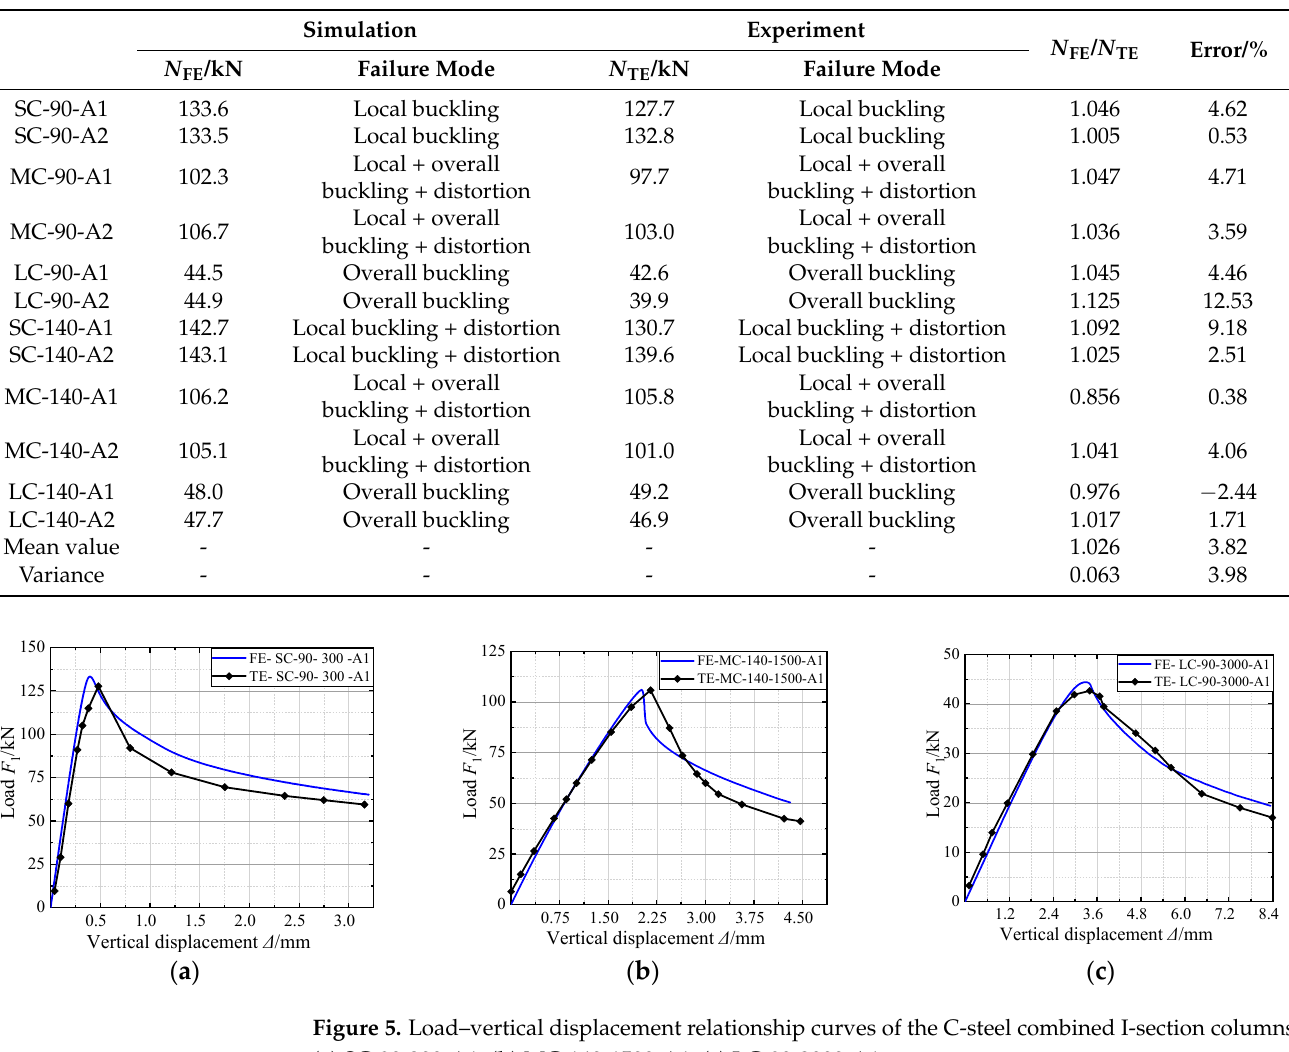
Table 2. Comparisons between the simulated and tested compressive bearing capacities.